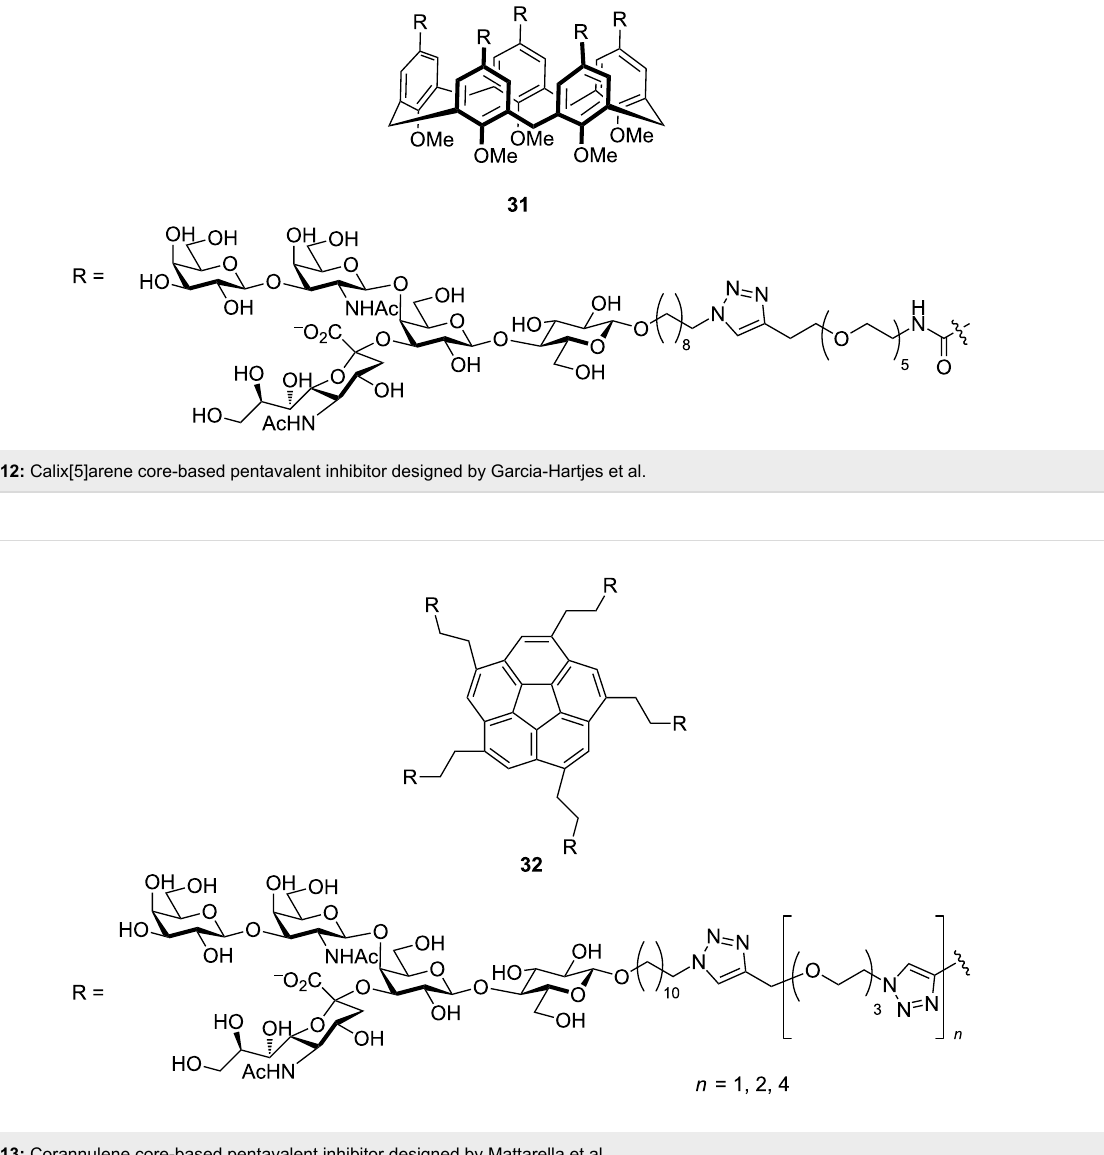
with appropriate spacing’s to maximize interactions with the target protein. Dynamic light scattering and analytical ultracen- trifugation demonstrated that the glycoprotein formed a 1:1 complex with the target CTB protein and was highly effec- tive as an inhibitor with an IC 50 value of 104